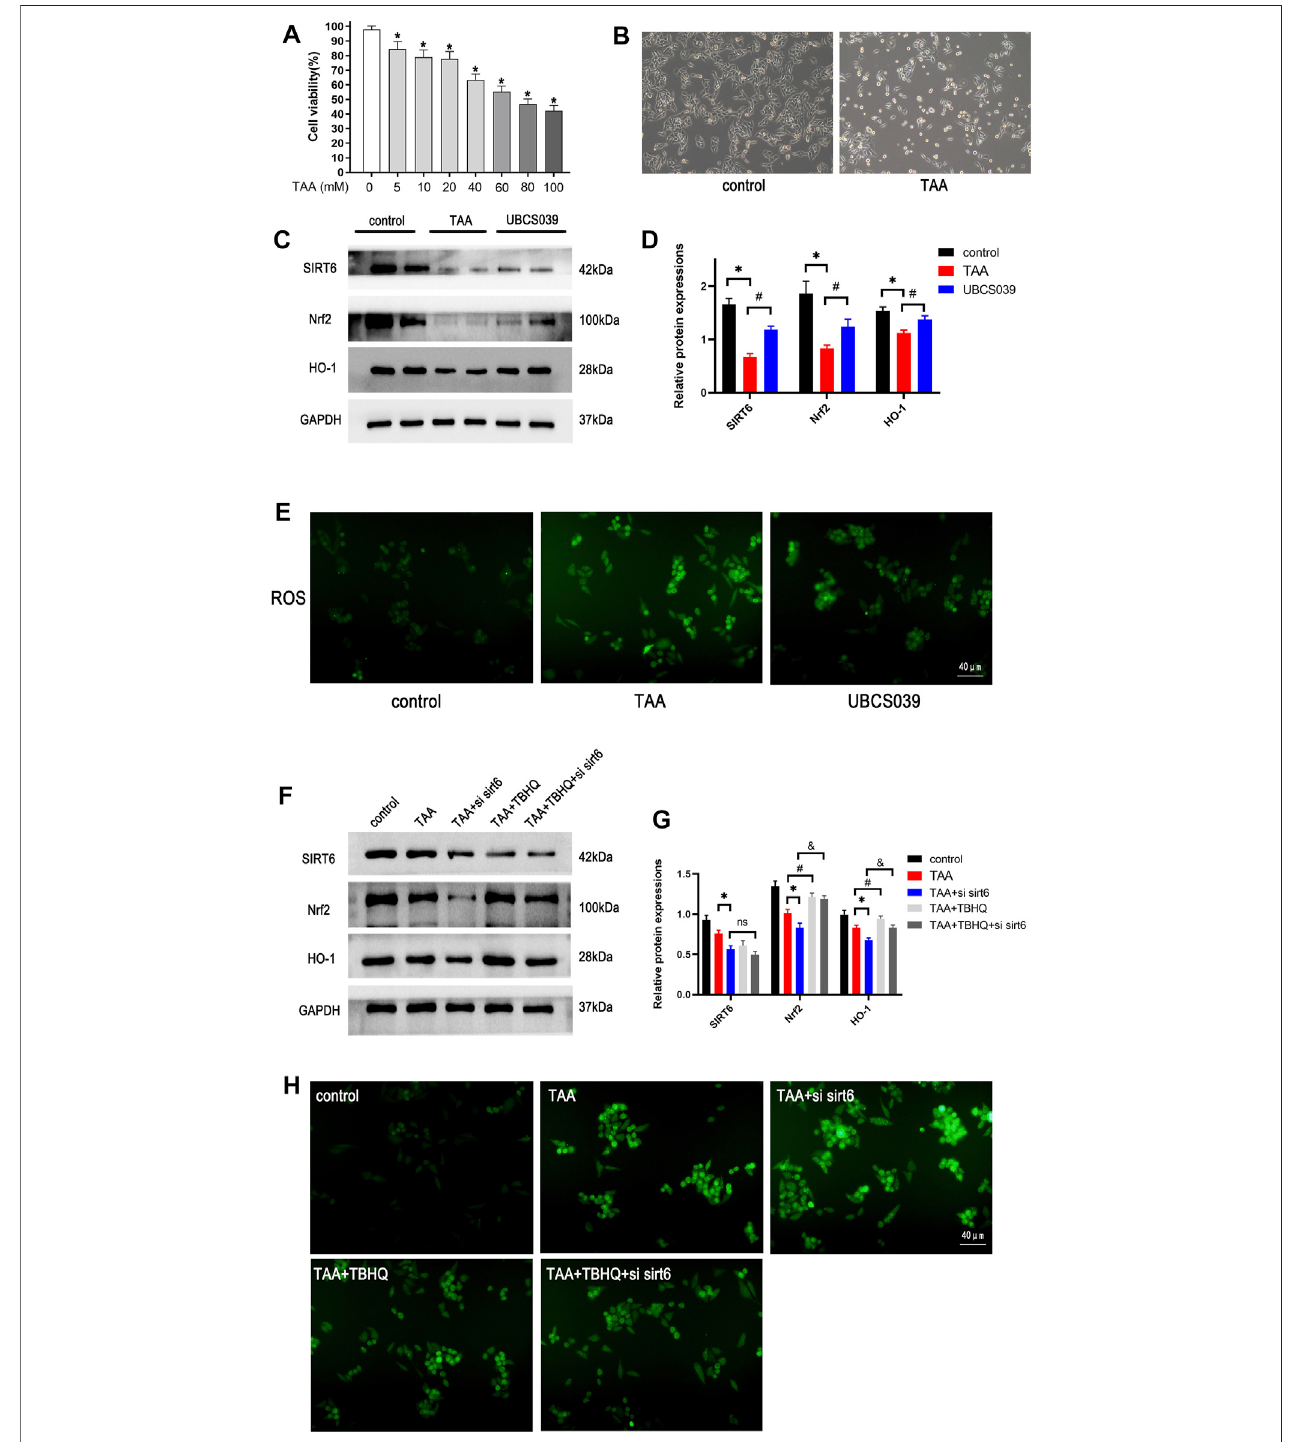
FIGURE 8 | Effects of SIRT6 on the Nrf2/HO-1 pathway in TAA-induced hepatocytes. (A) Toxic different doses of TAA were by CCK-8 assay. (B) LO2 cells were exposed to 50 μ M TAA; cellular morphology was observed under the light microscope. (C) Western blot analysis of SIRT6, Nrf2, and HO-1 levels in each group. (D) Densitometricanalysisoftheseproteins. (E) ROSwasobservedundera fl uorescencemicroscope. (F) Nrf2activator,20 μ MTBHQwasaddedincells,theNrf2pathway protein expression was analyzed by treatment with siRNA and TAA. (G) Densitometric analysis of these proteins. (H) ROS was observed under a fl uorescence microscope. n = 3 per group. Data are represented as mean ± SD.